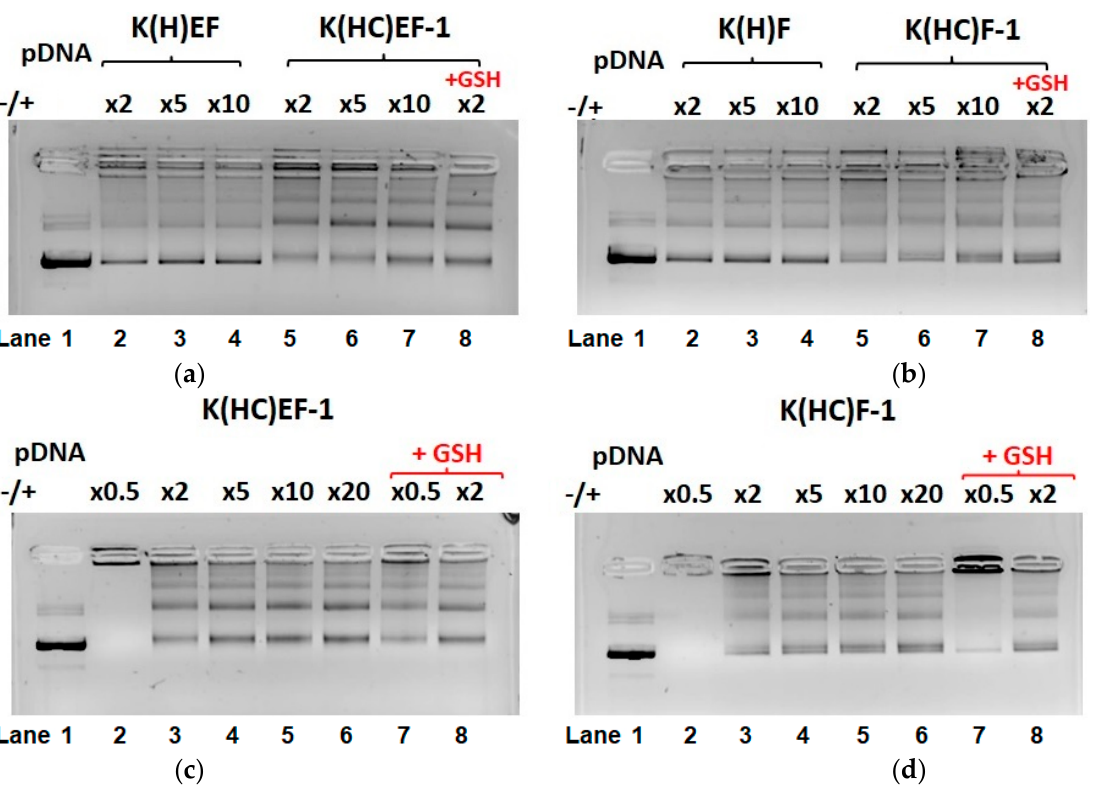
Figure 8. Heparin displacement test: ( a ) comparison of stability of pDNA complexes with precursor K(H)EF polypeptide and the S-S cross-linked K(HC)EF polypeptide nanoparticles at different excesses of heparin; ( b ) comparison of stability of pDNA complexes with precursor K(H)F polypeptide and the S-S cross-linked K(HC)F polypeptide nanoparticles at different excesses of heparin; ( c ) effect of different concentrations of heparin and glutathione on the stability of pDNA complexes with the S-S cross-linked K(HC)EF polypeptide nanoparticles; ( d ) effect of different concentrations of heparin and glutathione on the stability of pDNA complexes with the S-S cross-linked K(HC)F polypeptide nanoparticles.